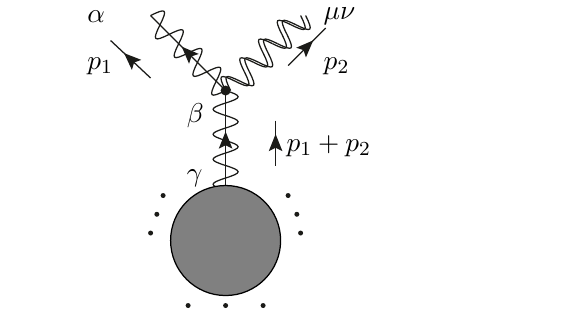
Figure 9 . Feynman diagrams leading to soft gravitino singularities interacting with non-soft grav- itino.